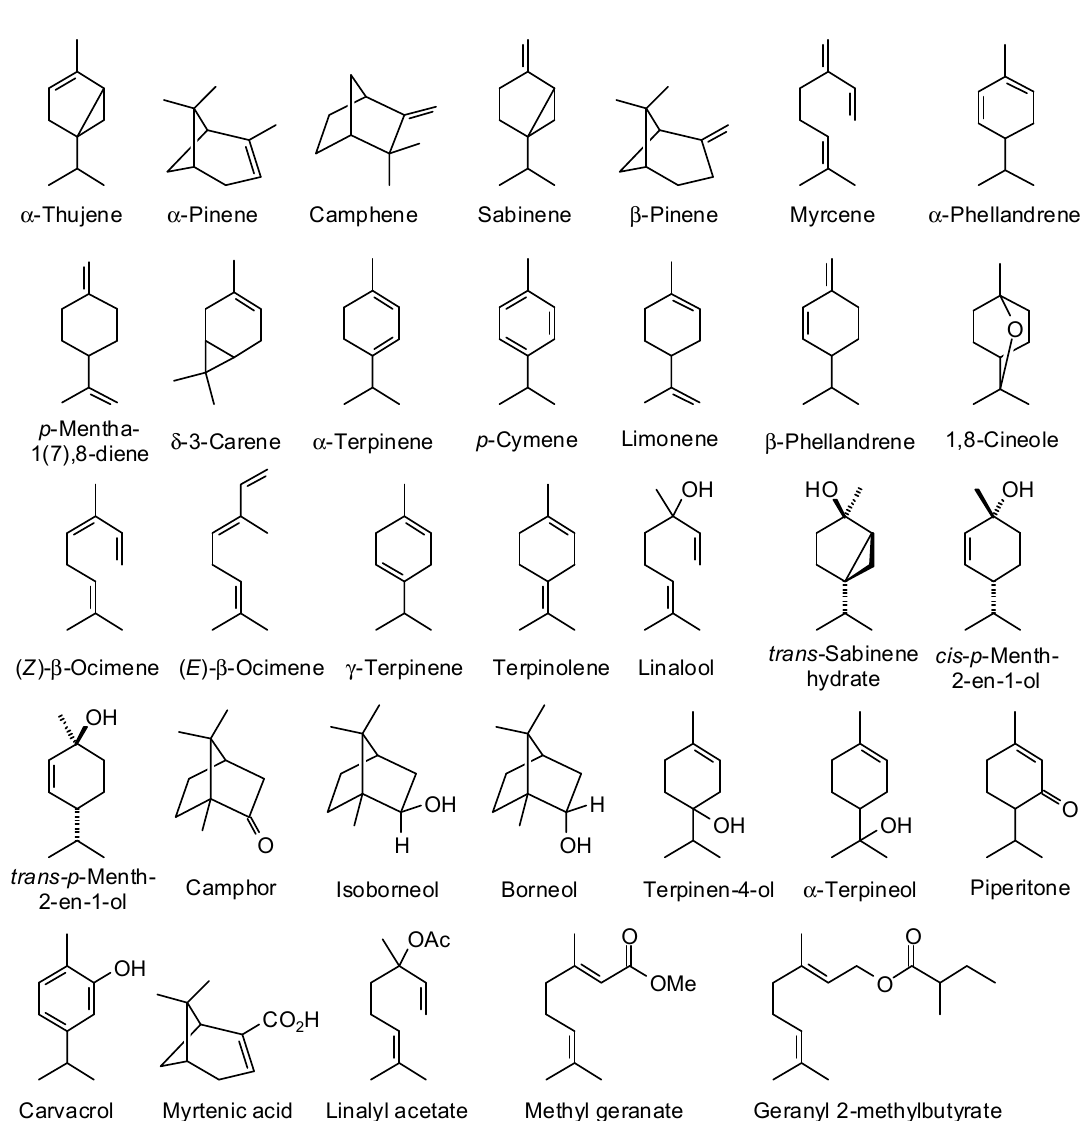
Figure A1. Major monoterpenoids found in Neotropical Piper species.